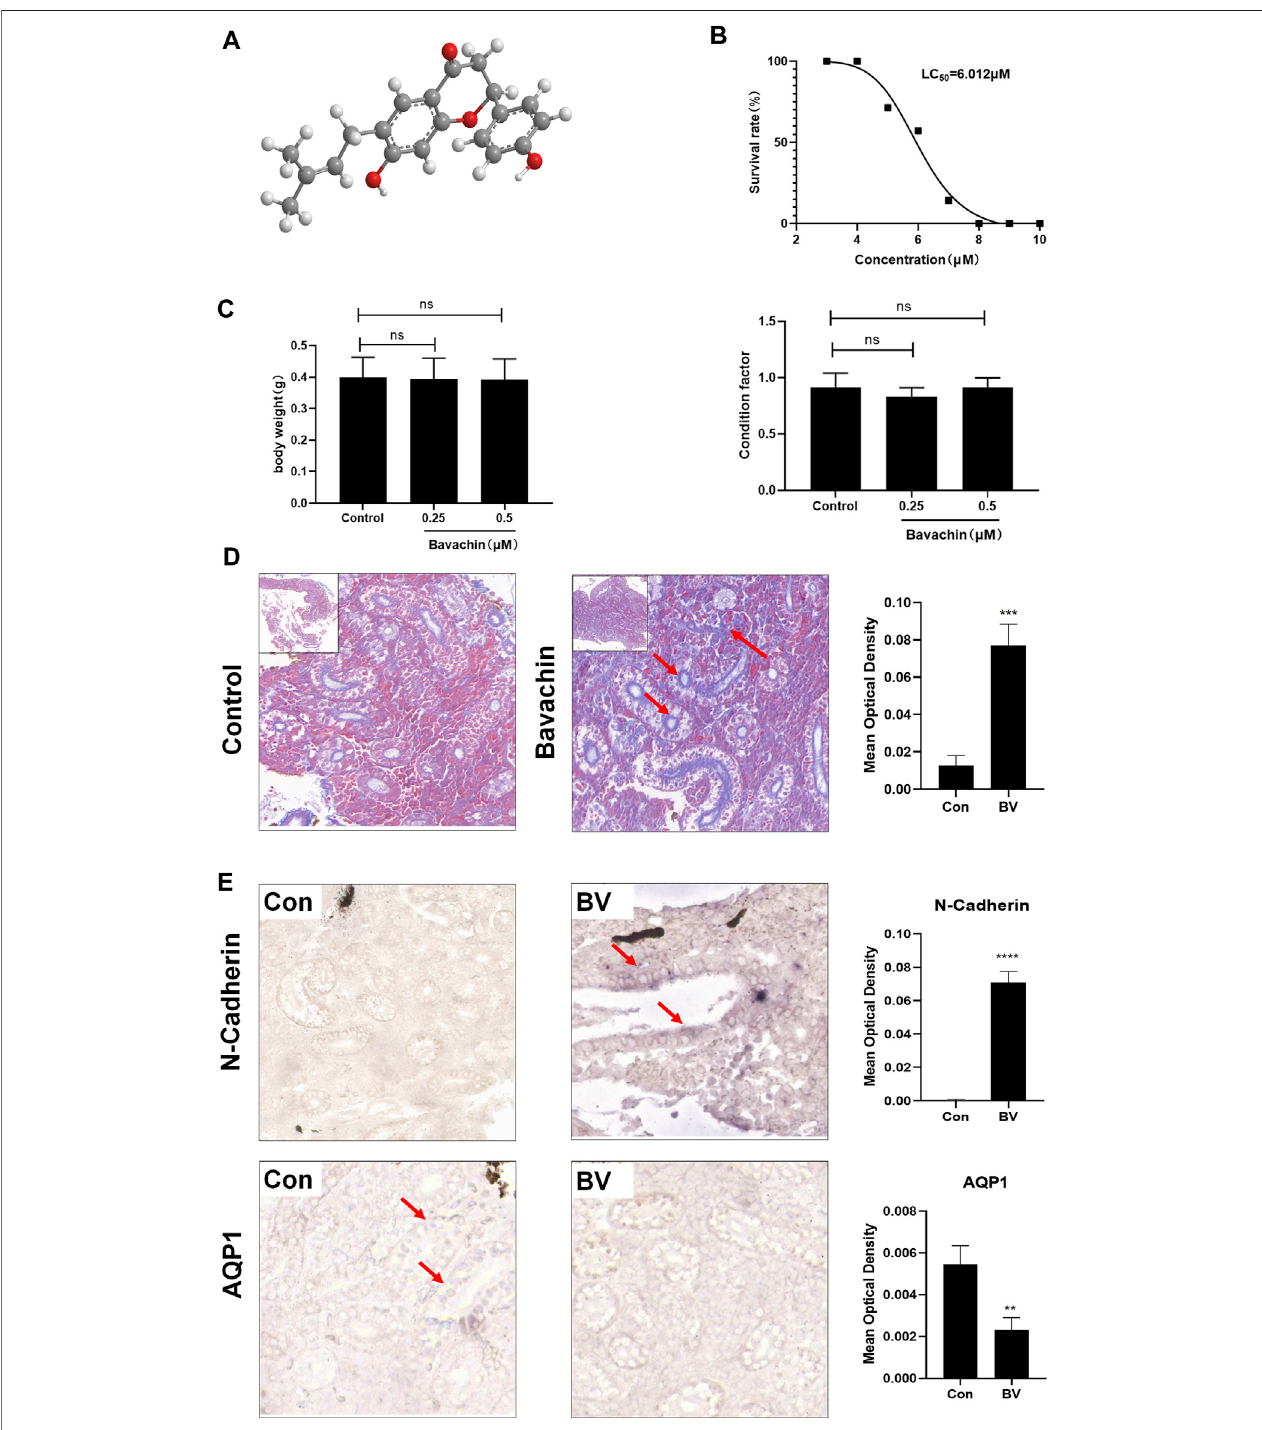
FIGURE1| Long-term treatment withalowdoseofBV-induced renal fi brosisinzebra fi sh. (A) ChemicalstructureofBV. (B) LC 50 ofBVonzebra fi sh after4daysof treatment was calculated. (C) Body weight and condition factor of zebra fi sh after 21 days BV treatment (n = 30). (D) Masson trichrome staining of zebra fi sh kidney treated with solvent or BV, respectively. (E) The contents of N-cadherin and AQP1 in zebra fi sh kidneys were detected by in situ hybridization. ns means no signi fi cant difference. ** p < 0.01, *** p < 0.001, and **** p < 0.0001 vs. the control groups.